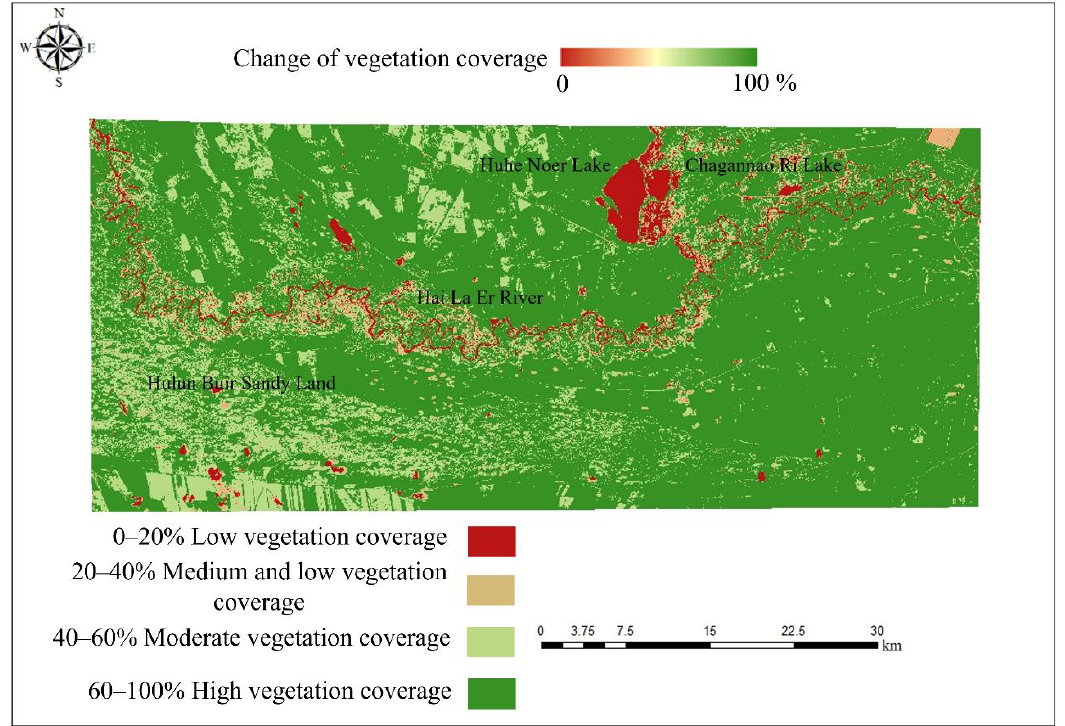
Figure 7. Vegetation coverage in the lower reaches of the Hai La Er River in 2021.